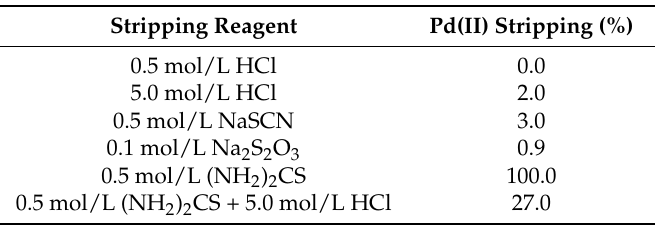
Table 10. Stripping of Pd(II) in loaded mixture phase of 5,8-diethyl-7-hydroxyldodecane-6-oxime (LIX 63) and Alamine 336 using various reagents.